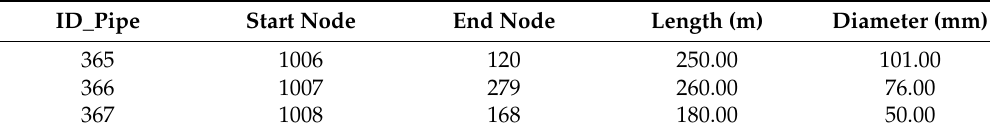
Table 6. New pipes added to the FRM network.